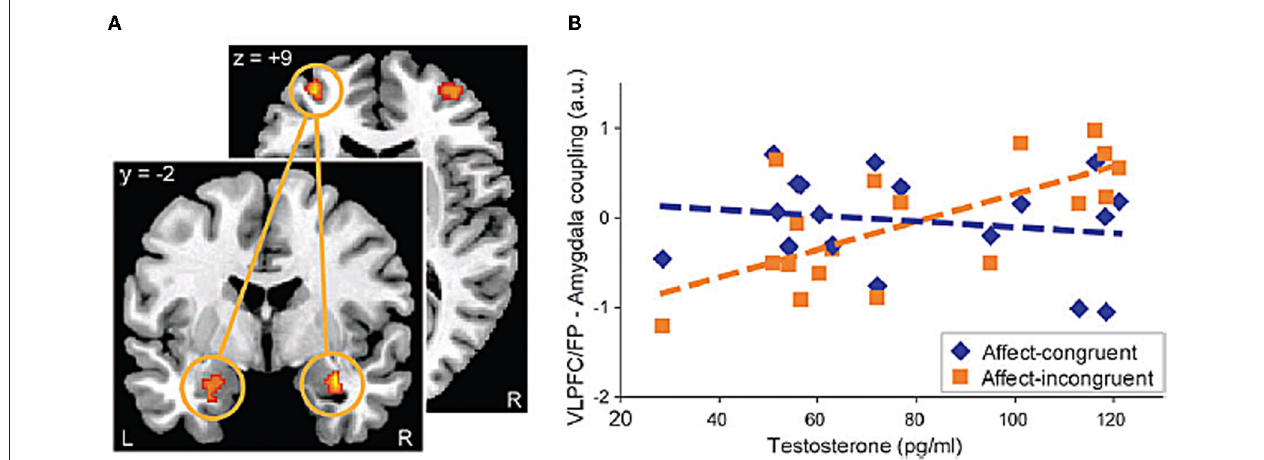
FIGURE 1 | Example of the effects of testosterone on the functional connectivity between prefrontal cortical regions (i.e., VLPFC/FP) and subcortical regions (i.e., amygdala) during a task that recruits cognitive-affective processes. (A) Coupling between left VLPFC/FP and right amygdala, which was significantly (FWE, p < 0 . 05) modulated by